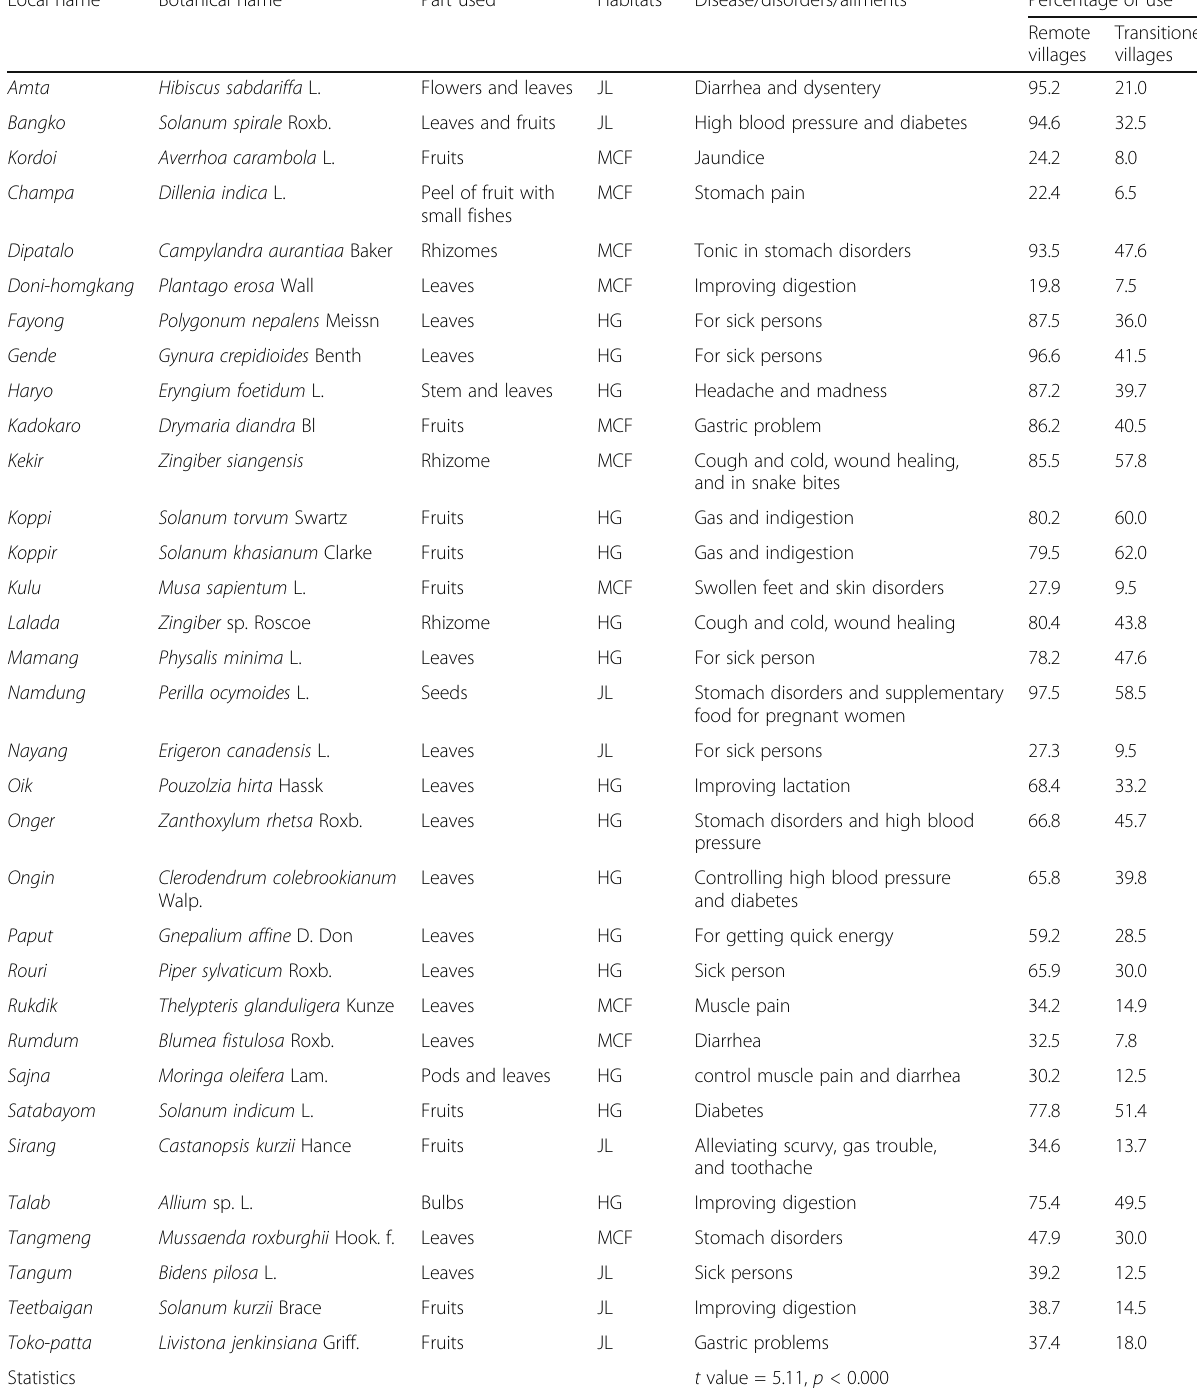
Table 2 List of major ethnobotanicals used as food-cum-ethnomedicine by the Adi women Local